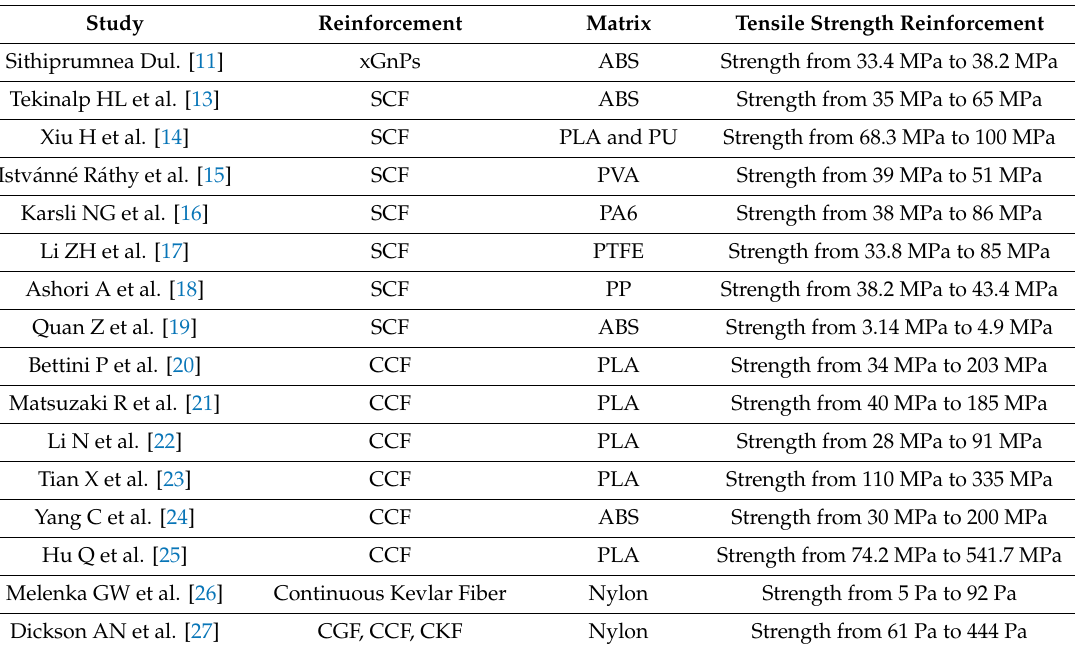
Table 1. The overview of studies on printing of reinforced filaments.xGnPs: graphene